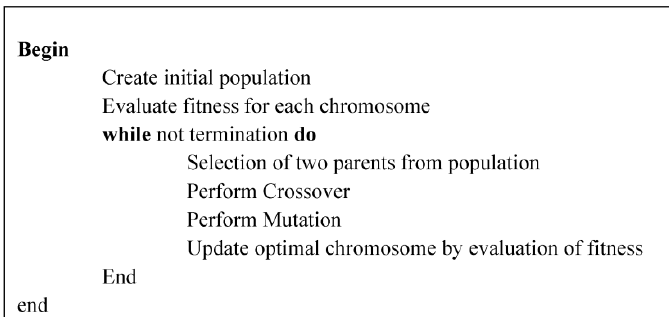
Figure 7. A simple procedure of Genetic